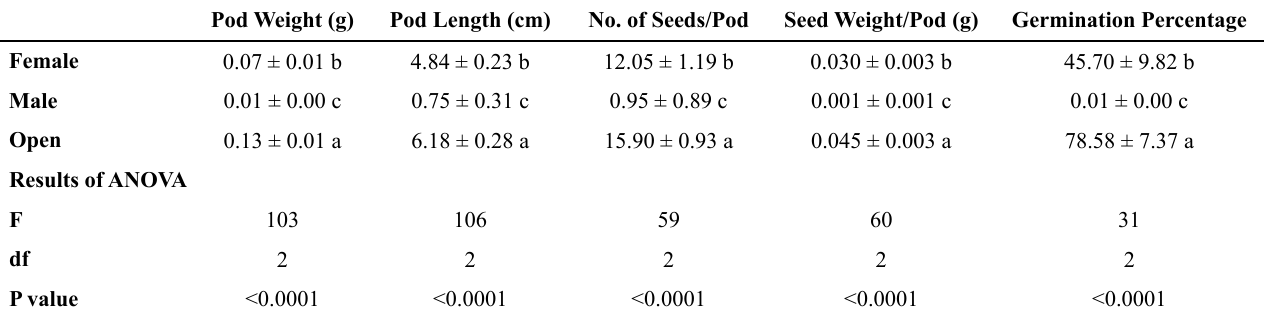
Table 5 . Pod weight, pod length, number of seeds/pod, seed weight/pod and germination percentage resulting from single visit by female and male A. savignyi .